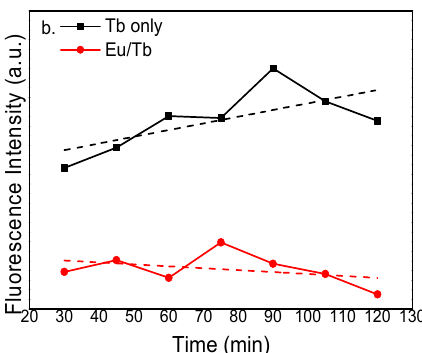
Figure 7. Fluorescence emission intensity of PVA fluorescent gel of ( a ) Eu and ( b ) Tb for different reaction times.